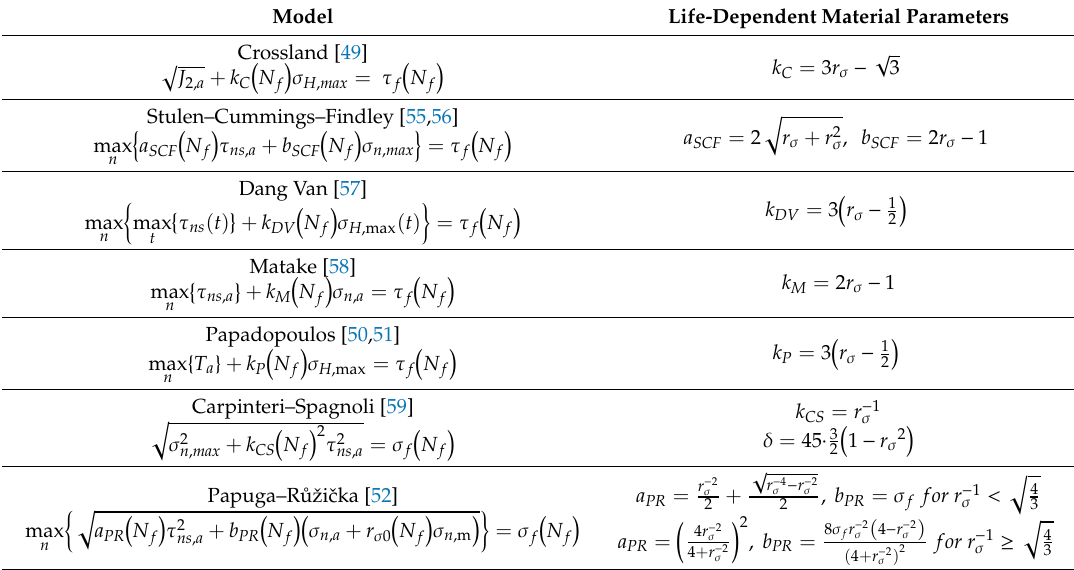
Table 1. Selected models for fatigue life estimation with the life-dependent material parameters.